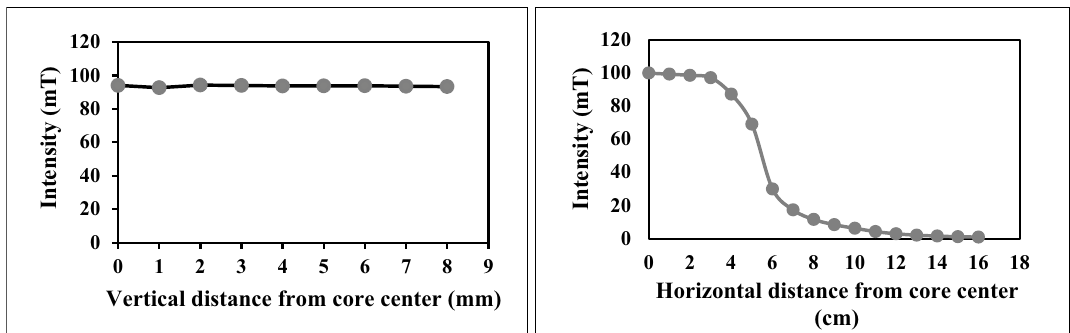
Figure 3. The intensity of the magnetic field at various distances from the